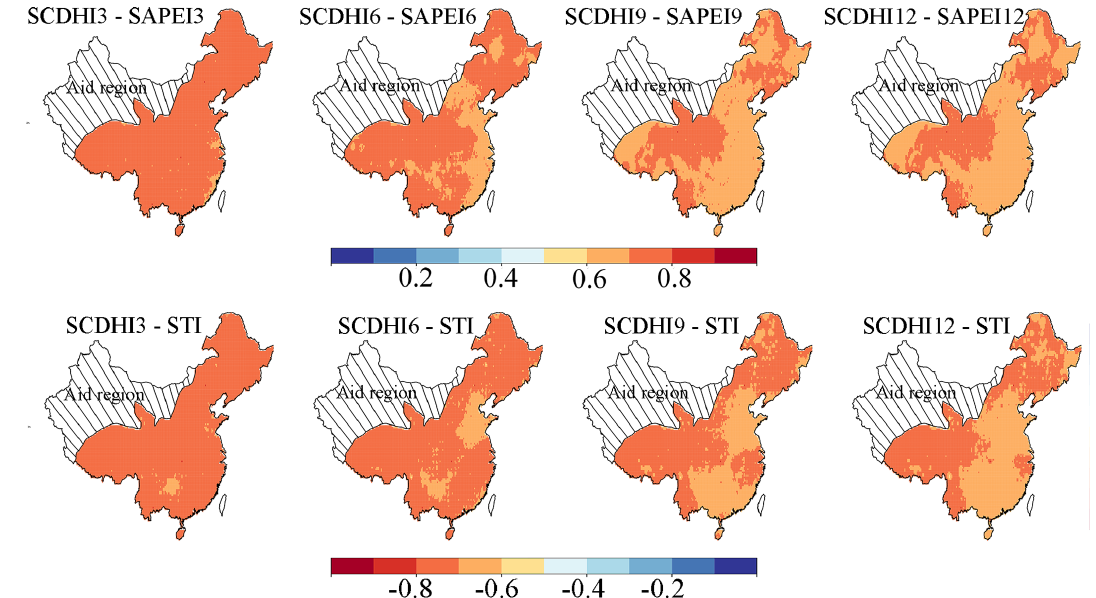
Figure 7. The correlation between the SAPEI/STI and SCDHI during the historical period